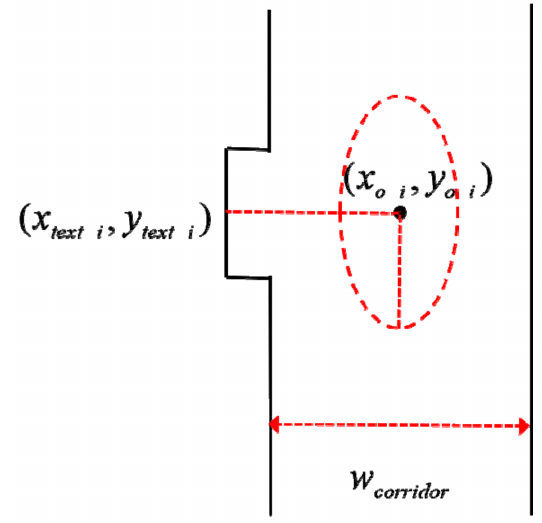
Figure 7. Initial potential area of the